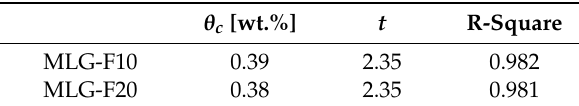
Table 3. Fitting Table 3. Fitting parameters.